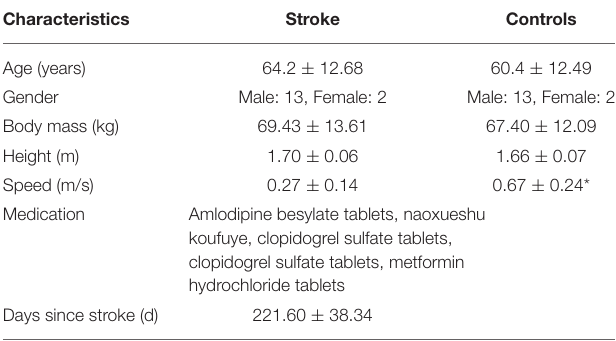
TABLE 1 | Demographic characteristics of the individuals ( N =